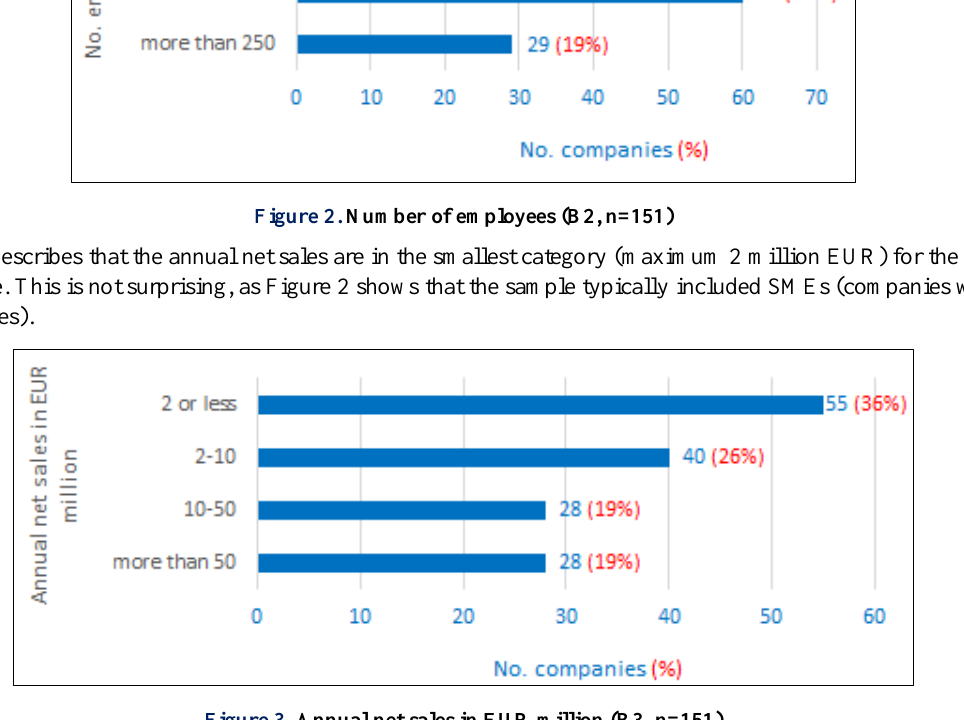
Figure 3. Annual net sales in EUR million (B3, n=151)